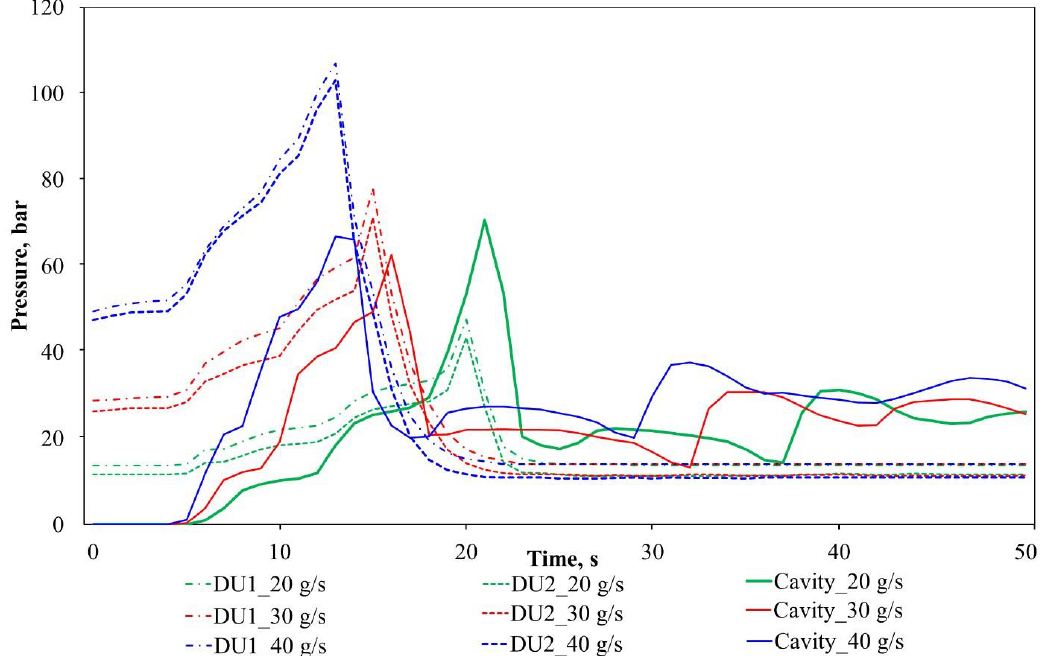
Figure 11. The pressure curves of the reinforced PA-6 during the T-RTM process.